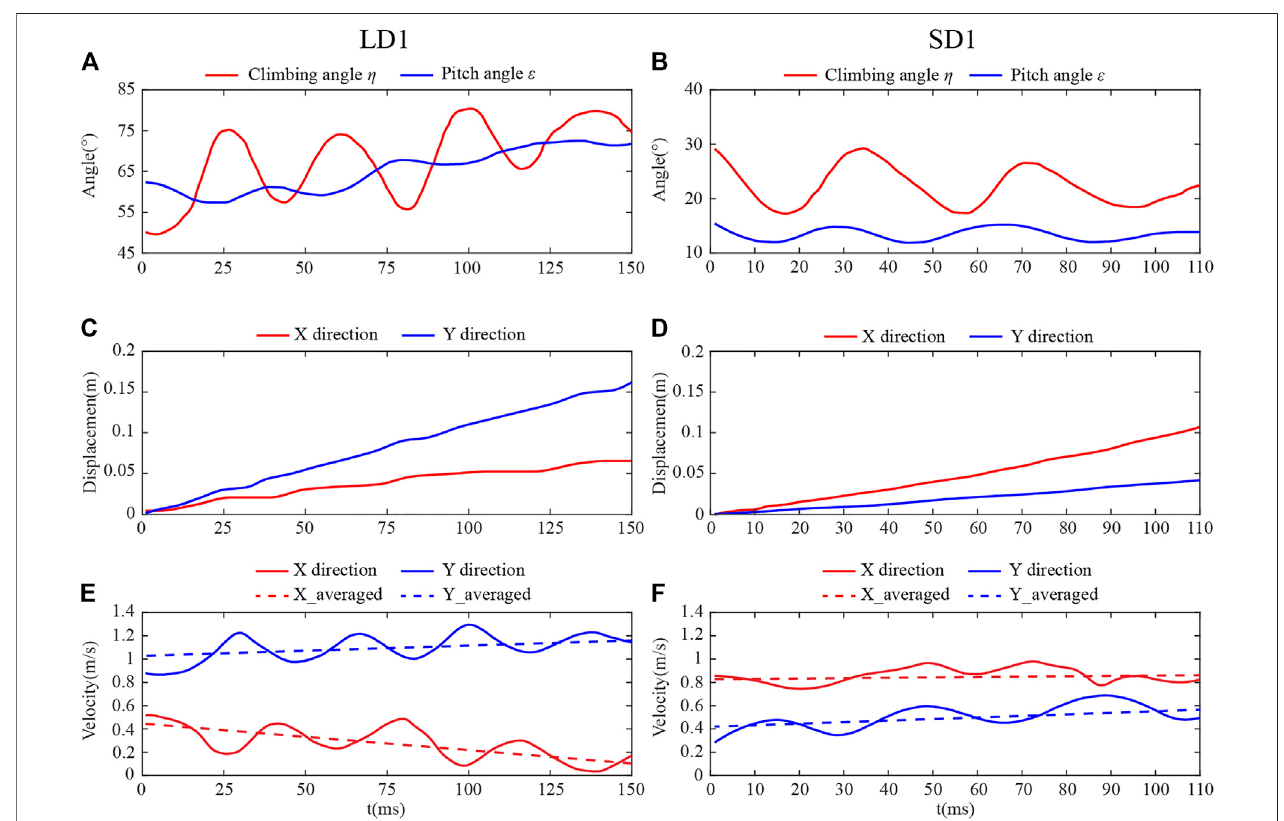
FIGURE 4 | Body posture angles for (A) LD1 and (B) SD1. Flight displacement of (C) LD1 and (D) SD1. Flight velocity of (E) LD1 and (F) SD1.